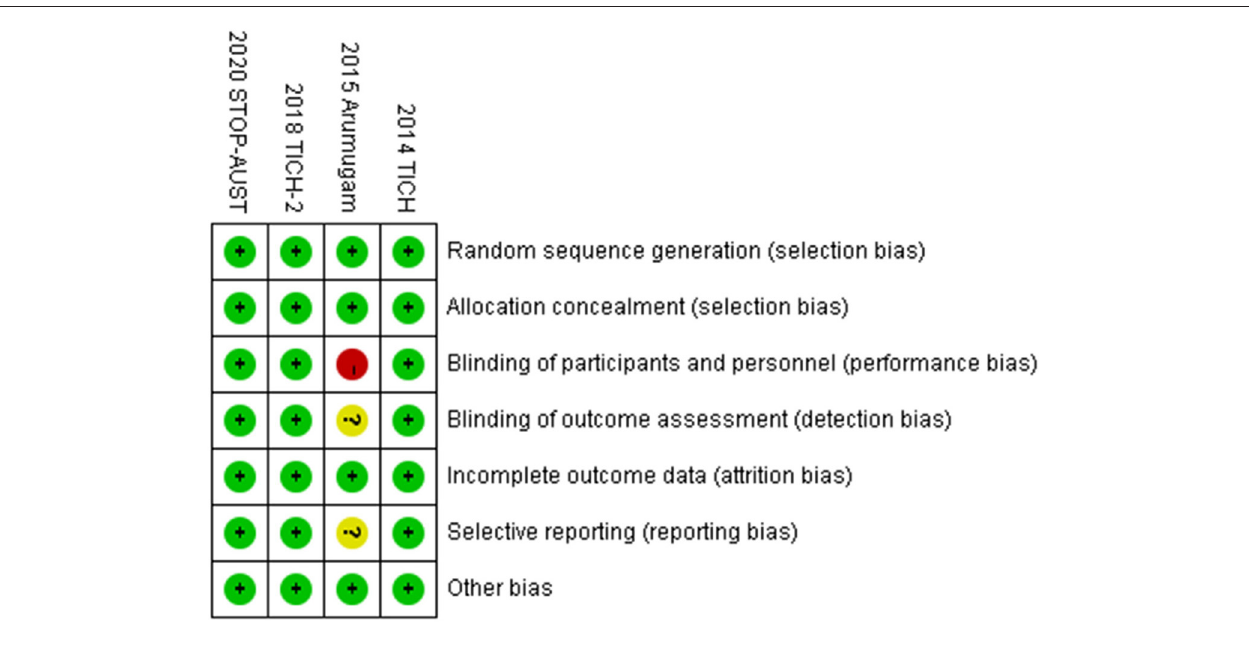
FIGURE 4 | Risk of bias: a summary table for each risk of bias item for each study.